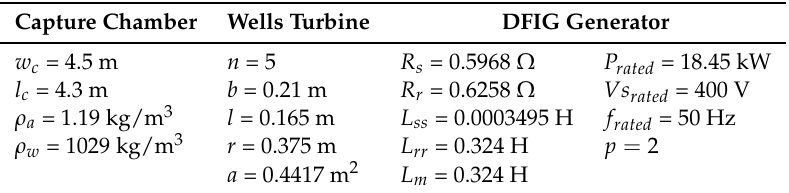
Table 1. OWC parameters from the NEREIDA wave power